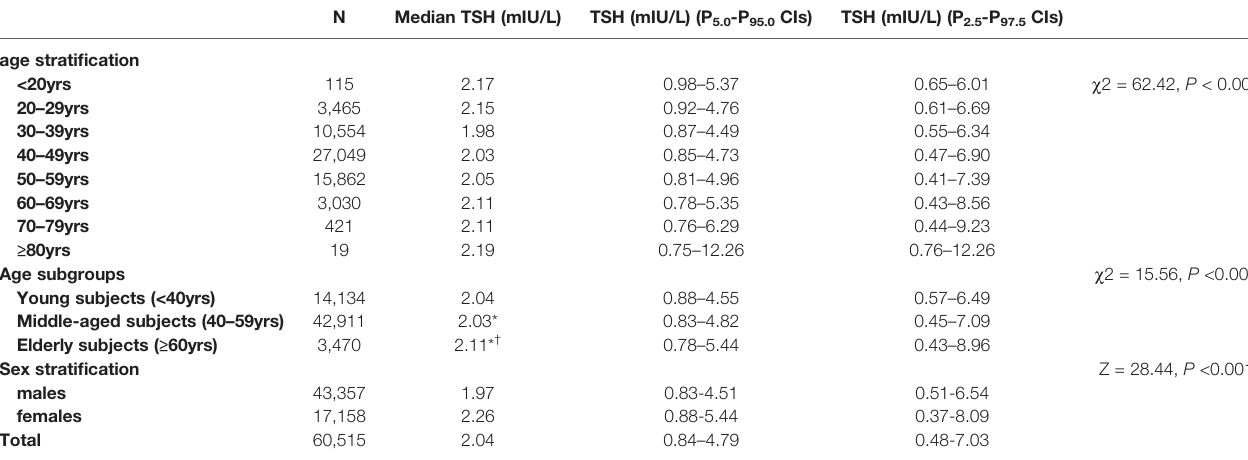
TABLE 4 | Distributions of TSH concentrations in the different strati fi cation in the speci fi c group (n=60,515). N Median TSH